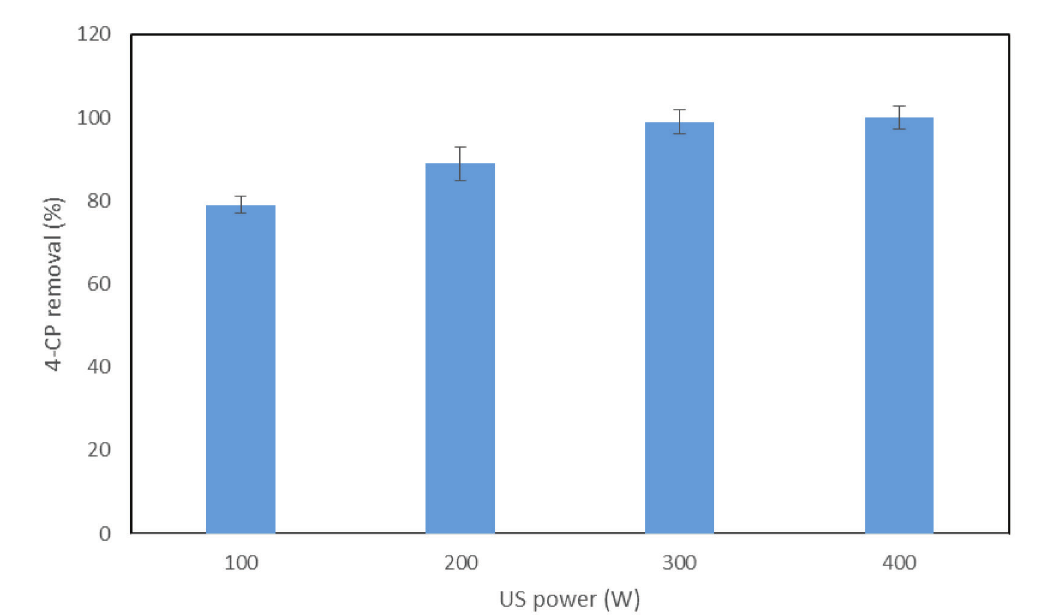
Fig. 7 – Effect of US power on 4-CP removal (initial 4-PC concentration of 100 mg L –1 , solution pH 5, catalyst dosage 0.8 g L –1 , and H O concentration of 20 2 2